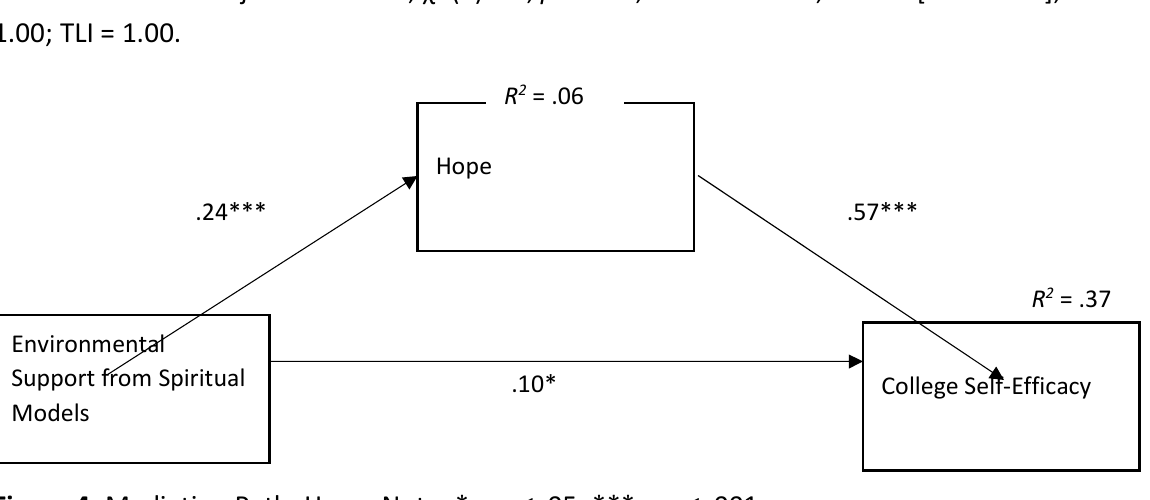
Figure 4. Mediation Path: Hope. Note. * = p ≤ .05, *** = p ≤ .001 Moderation